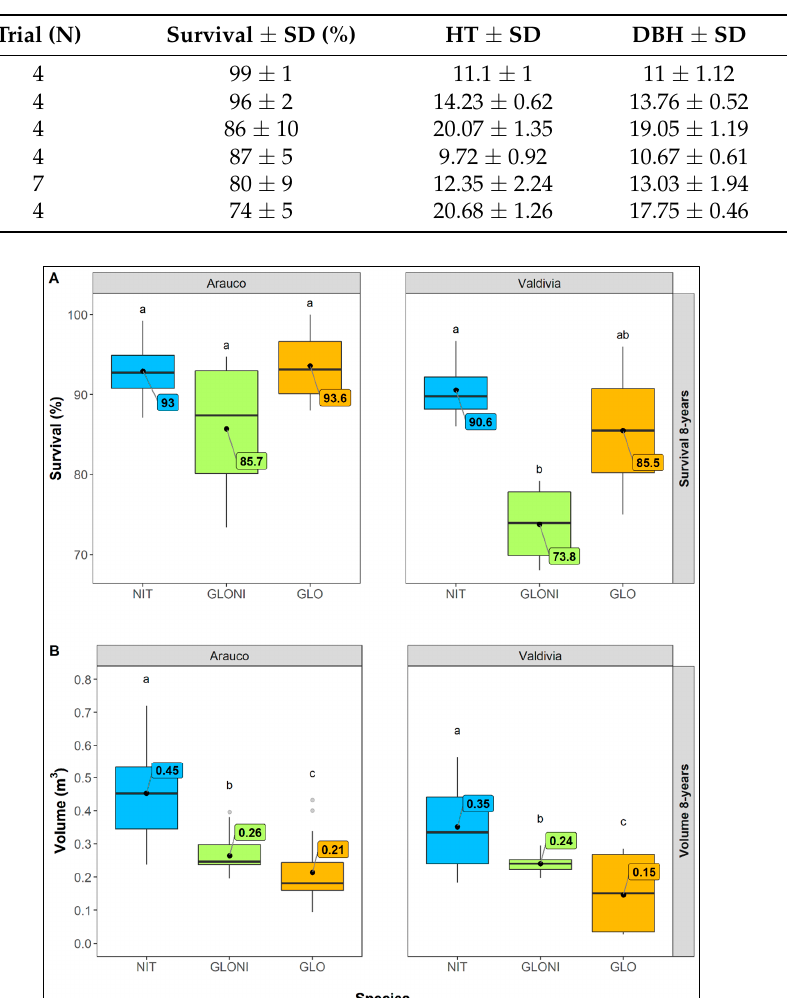
Table 2. Summary of field test growth measurements per age and breeding zone. HT = Total tree height (m), DBH = diameter measured at 1.3 m above ground (cm). The means of the growth traits and their standard deviations (SD) are provided for each zone and age.